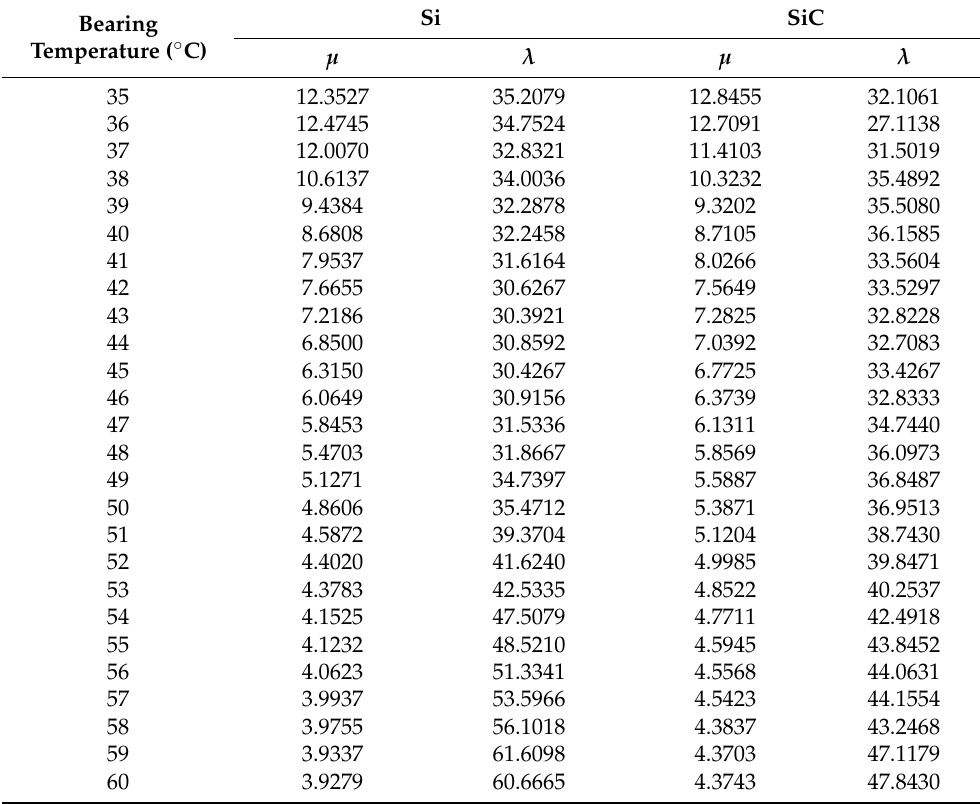
Figure 20. Mean and shape parameters of the shaft breakdown voltage inverse Gaussian distribu- tions plotted against temperature.